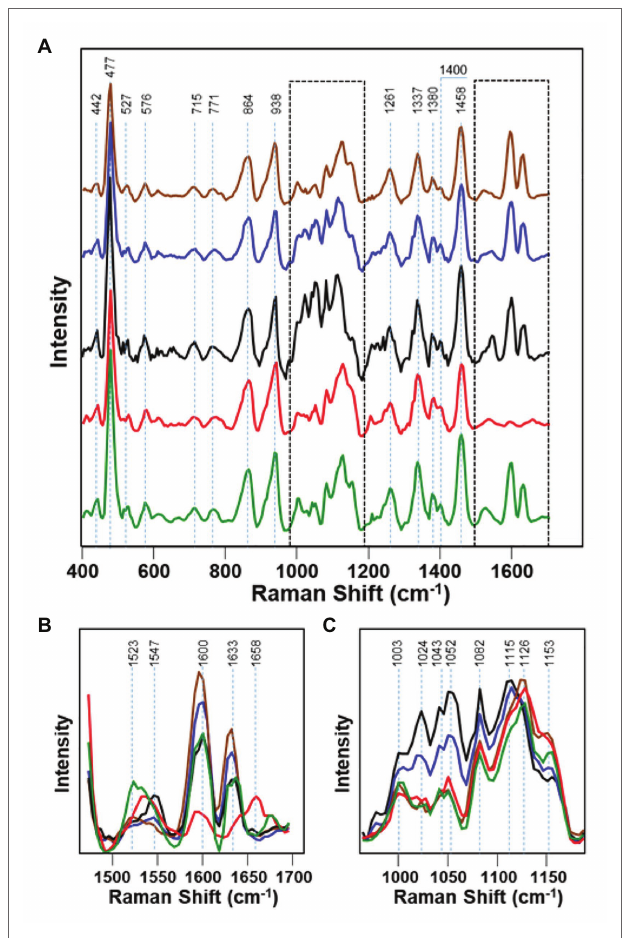
FIGURE 5 | Raman spectra of healthy maize kernels (green) and maize kernels infected by Aspergillus niger (brown), A. flavus (blue), Diplodia spp. (black), and Fusarium spp. (red). 1450-1700 cm-1 and 950-1200 spectral regions shown by dashed lines in the panel A are magnified in panels B and C , respectively. Reproduced with permission from Farber and Kurouski,